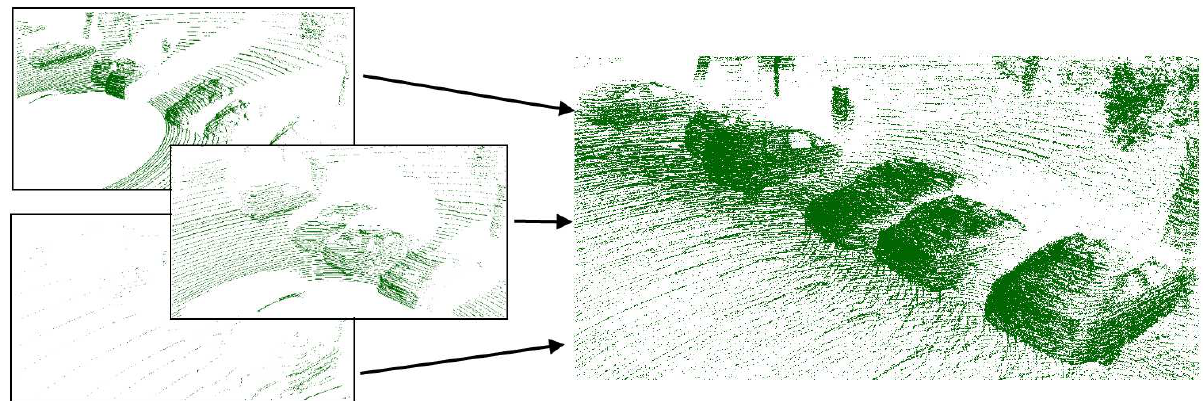
Figure 3: Image sequence showing the registration process. Right side image contains 20 registered